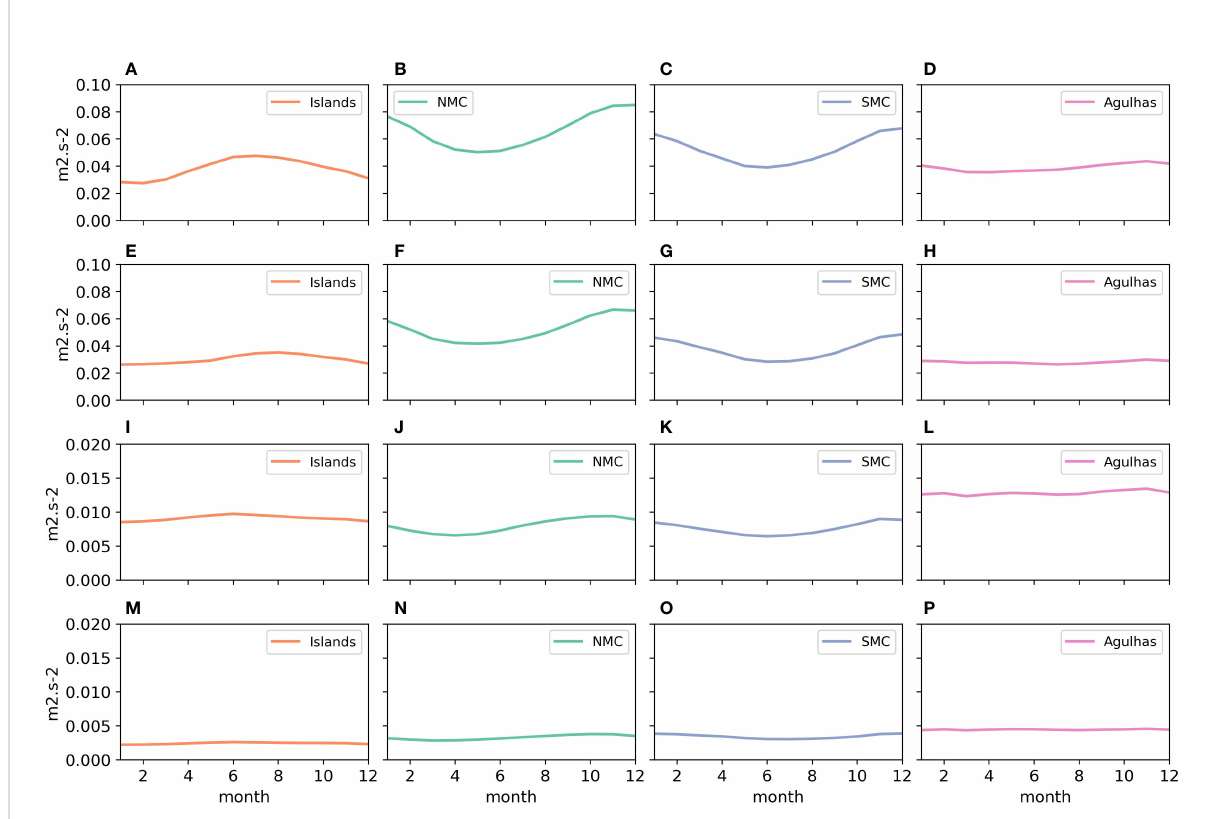
FIGURE 9 MOZ36 EKE climatology for each subregion at surface (A-D) , -100 m (E-H) , -500 m (I-L) , -1000 m (M-P) . Please note the different y-axis